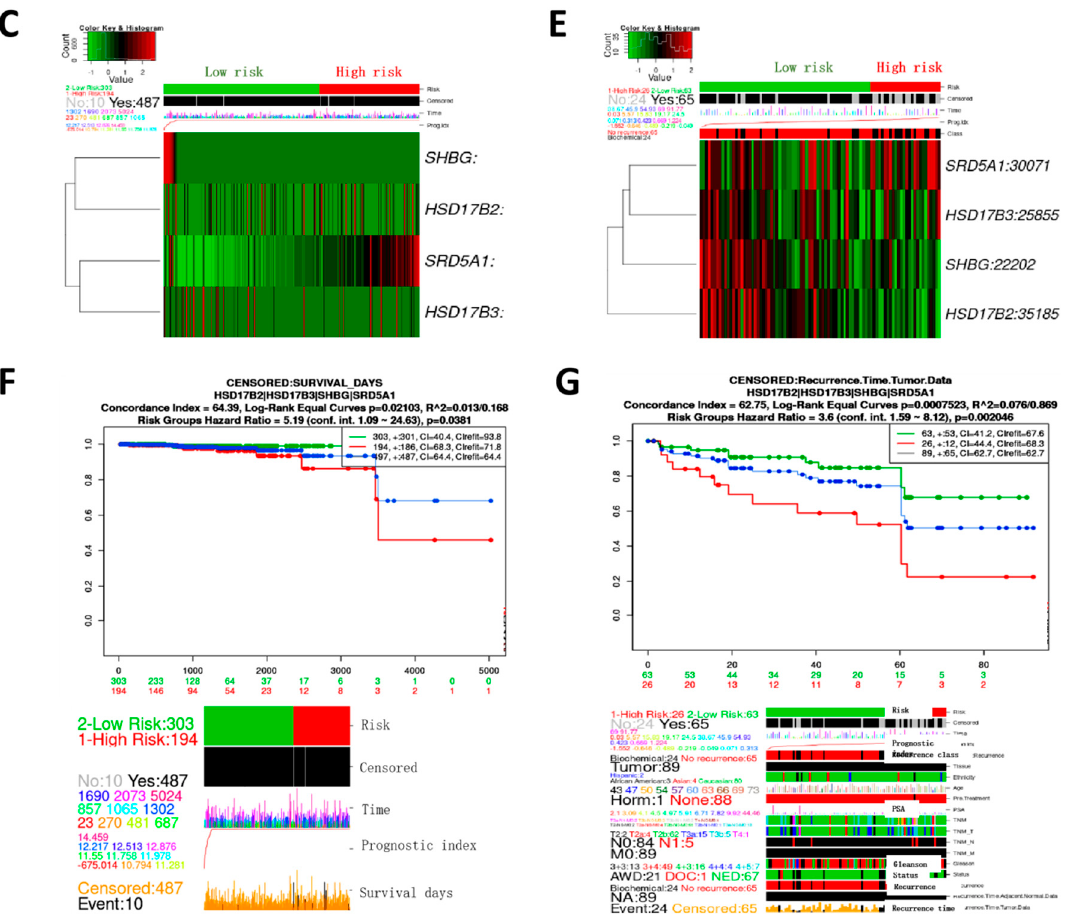
Figure 2. Variation in HSD17B2, HSD17B3, SHBG, and SRD5A1 expression co-occur and concertedly bear significant prognostic relevance in patients with PCa. ( A ) Depiction of mutual exclusivity or co-occurrence analysis using a multi- source pooled primary and metastatic PRAD cohort (N = 4369 patients/4498 samples). ( B ) Graphical representation and ( C ) heatmap of the association between HSD17B2, HSD17B3, SHBG, or SRD5A1 gene expression and death risk in the TCGA PRAD cohort. ( D ) Graphical representation and ( E ) heatmap of the association between HSD17B2, HSD17B3, SHBG, or